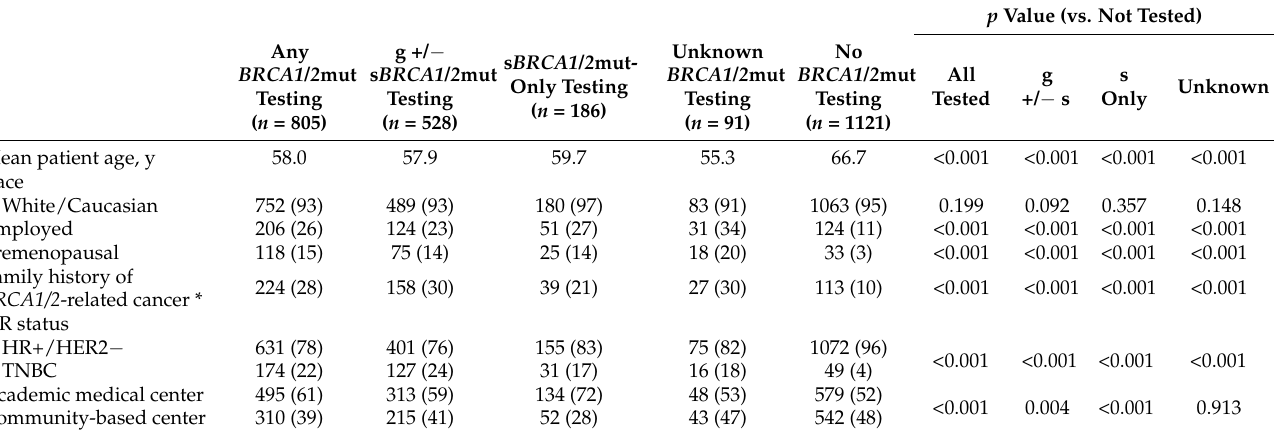
Table 5. Patient demographics and clinical characteristics by BRCA1/2 mut testing status among patients with HER2– ABC in the